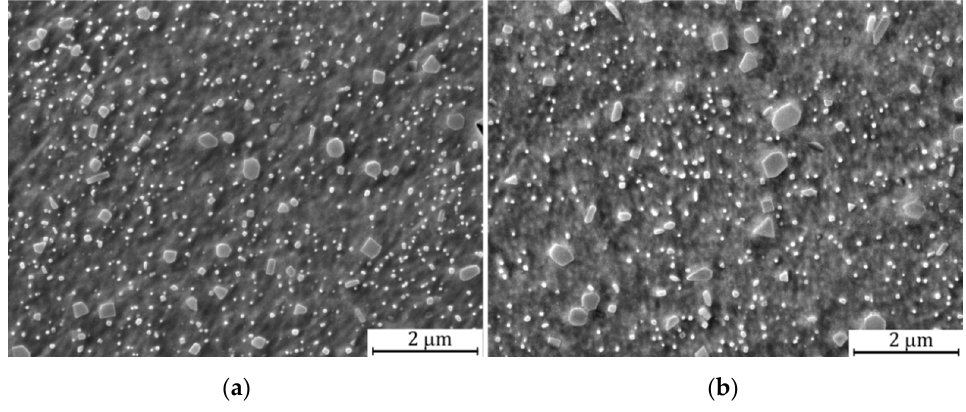
Figure 9. The micrographs of dispersoid aged at 1400 °C for 32 h ( a ) and 72 h ( b ).